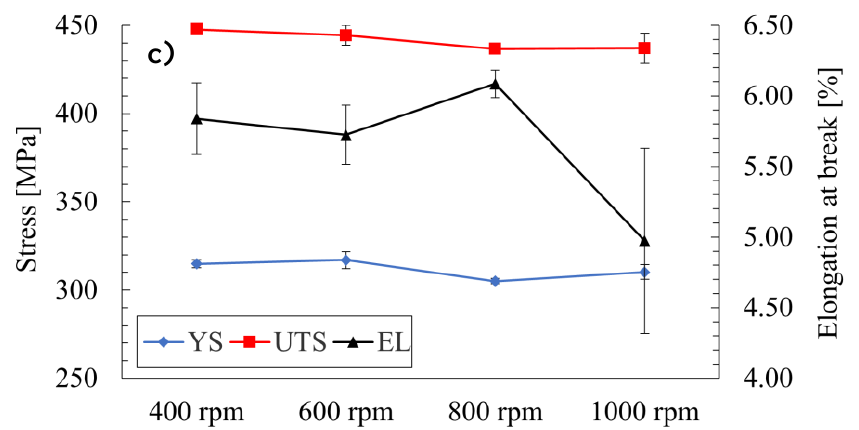
Figure 4. Influence of the tool rotation speed on yield strength (YS), ultimate tensile strength (UTS) and elongation at break (EL) for various values of welding speed: 50 mm/min ( a ), 75 mm/min ( b ) and 100 mm/min ( c ).